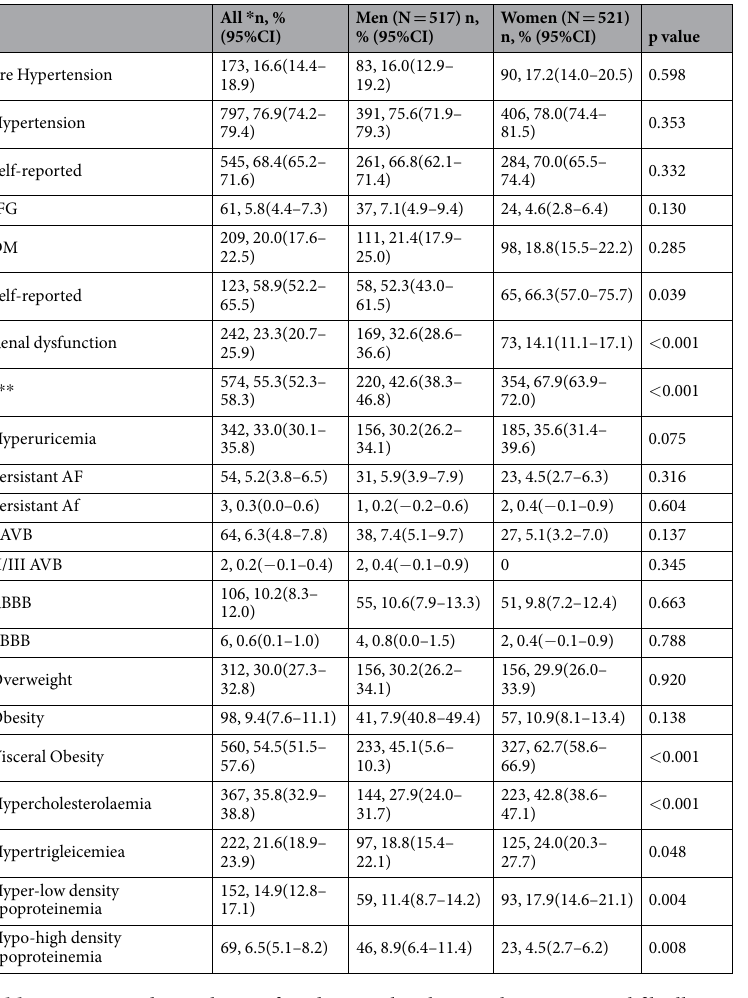
Table 2. Estimated prevalence of cardiovascular abnormalities. AF, atrial fibrillation; Af, atrial flutter; AVB, atrial ventricular block; DM, diabetes mellitus; FG, fast glucose; IFG, impaired fasting glucose; LBBB, = left bundle brach block; RBBB, right bundle brach block. Data are presented as and as number, frequency (95% confidence interval). * Prevalences are standardized for age and sex. ** Prevalence of renal dysfunction was defined as e GFR < 60 ml/(min · 1.73 m 2 ) according to Cockcroft-Gault